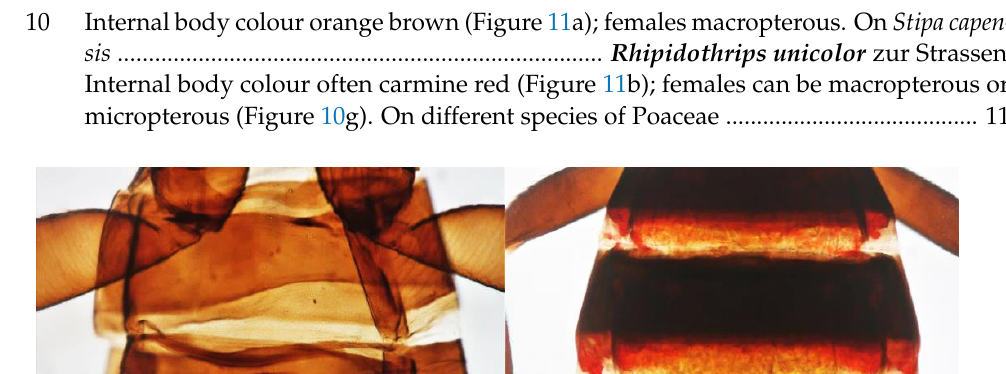
Figure 11. Abdominal segments II and III showing internal body color: ( a ) brown; ( b ) red. 11 Abdominal tergites with microtrichia on sculpture lines (Figure 12a); females usually Abdominal tergites with no microtrichia on sculpture (Figure 12b); females usually